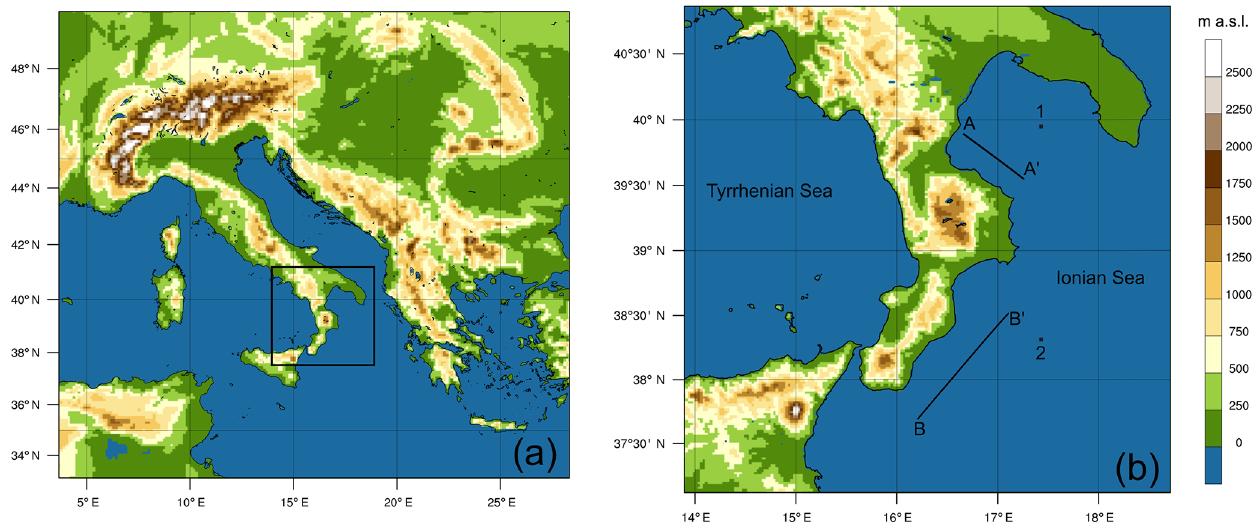
Figure 3. (a) The outer domain (D01) with a spatial resolution of 10km; (b) the inner domain (D02) with a spatial resolution of 2km. Points 1 and 2 are considered when evaluating SSTSK (skin SST) evolution locally during the events according to different configurations (Figs. 5 and 10 respectively). Vertically integrated water vapour fluxes are calculated across A–A’ and B–B’ (Figs. 9 and 13 respectively).